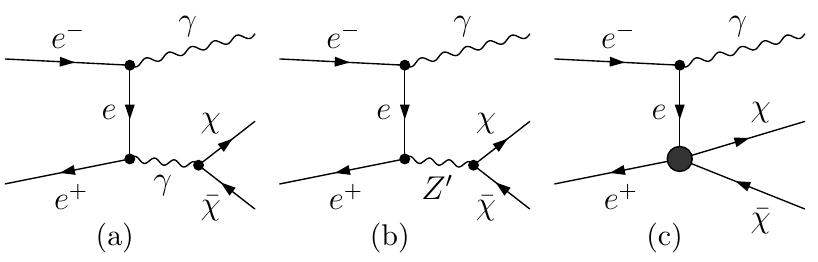
Figure 1 . Feynman diagrams for the process e + e (cid:0) ! (cid:31) (cid:22) (cid:31)(cid:13) in the millicharged DM models (a), in the Z 0 -portal DM models (b), and in the DM e(cid:11)ective operator formalism (c). Diagrams with photon radiated by the positron are included in the physics analysis but not shown here. The diagrams with photon emitted by the millicharged DM are neglected due to the small "